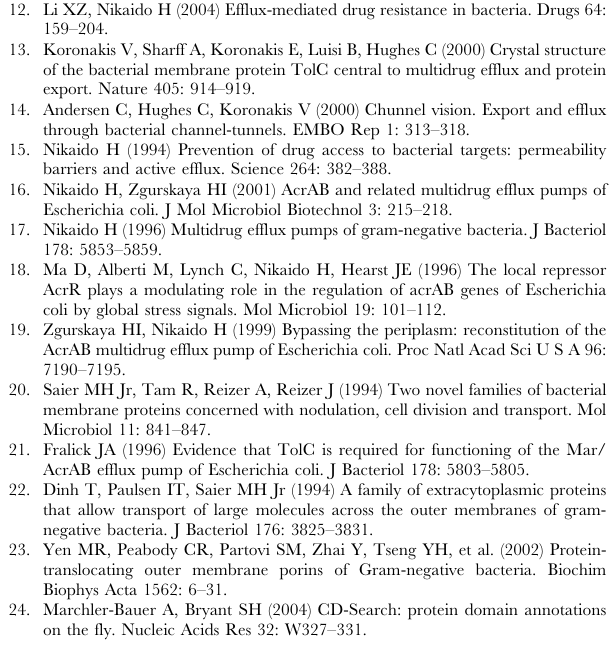
Table S1 Oligonucleotide primers used in this study. DOC) Table S2 Identification of BesC (BB0142) by peptide mass